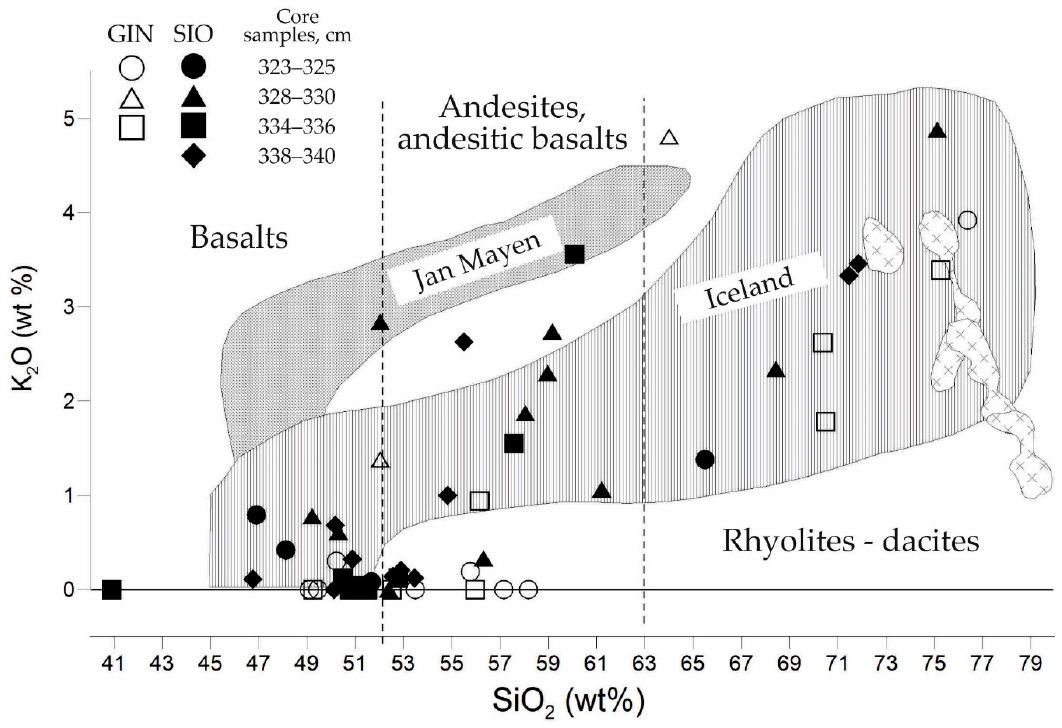
Figure 9. Position of the eruptive shards from the ash-bearing core unit of 323–340 cm in the binary SiO 2 / K 2 O system according to [24]. GIN (Geological Institute) samples present data on the shards in the natural state. SIO (Shirshov Institute of Oceanology) samples show data on the shards in the polished thin sections. Areas of the volcanic material from different sources are according to [25,26].